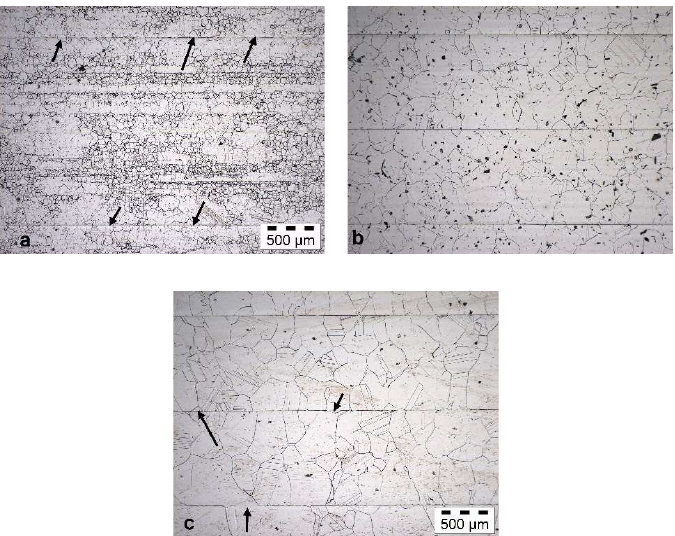
Figure 4. Resulting microstructure of Hastelloy BC-1 after diffusion bonding for t = 4 h at ( a ) T = 1100 °C; ( b ) T = 1150 °C; and ( c ) T = 1200 °C.